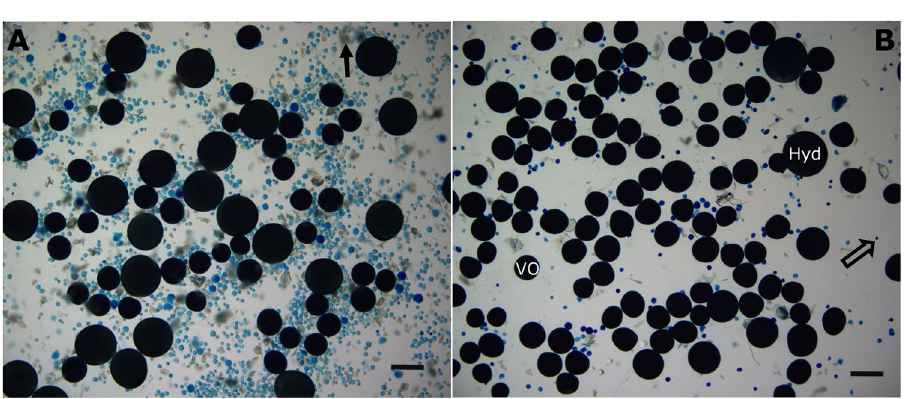
Figure 9. Representative whole-mount micrographs of stained samples with a relatively high (A ) and low ( B ) previtellogenic oocyte (PVO) count. PVO (hollow arrow), vitellogenic (VO), and hydrated (HYD) oocytes are indicated (in B ), as is ovarian debris (solid arrow) (in A ). Scale bar = 1000 µ m.